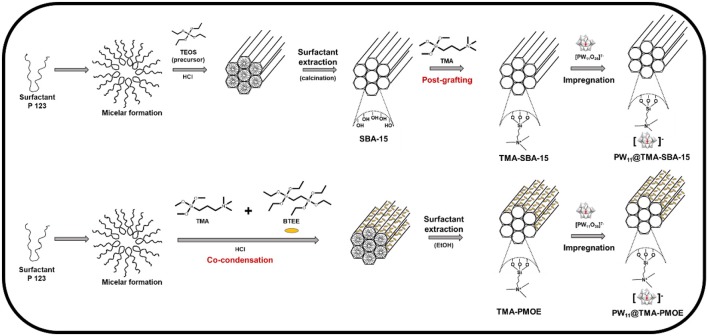
Representation of the synthetic pathway for the different PW11-based composites.